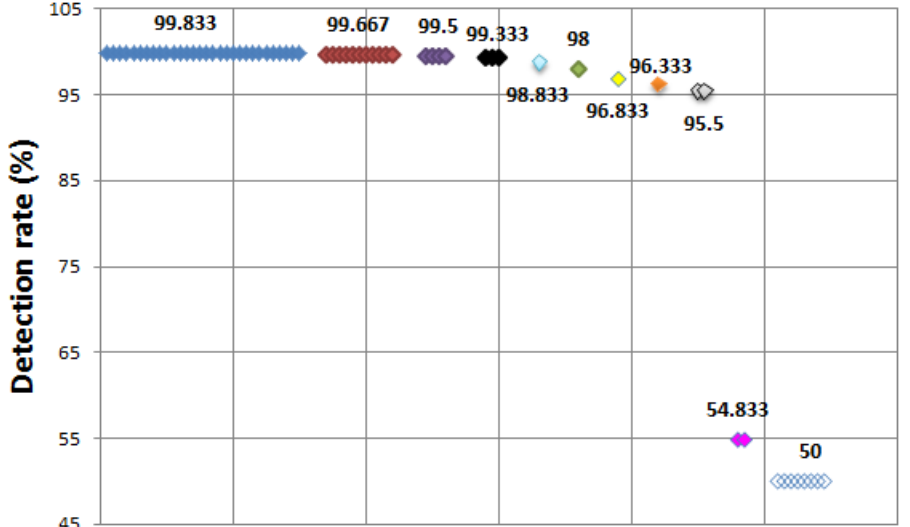
Figure 4. SYN flood attack—detection rate